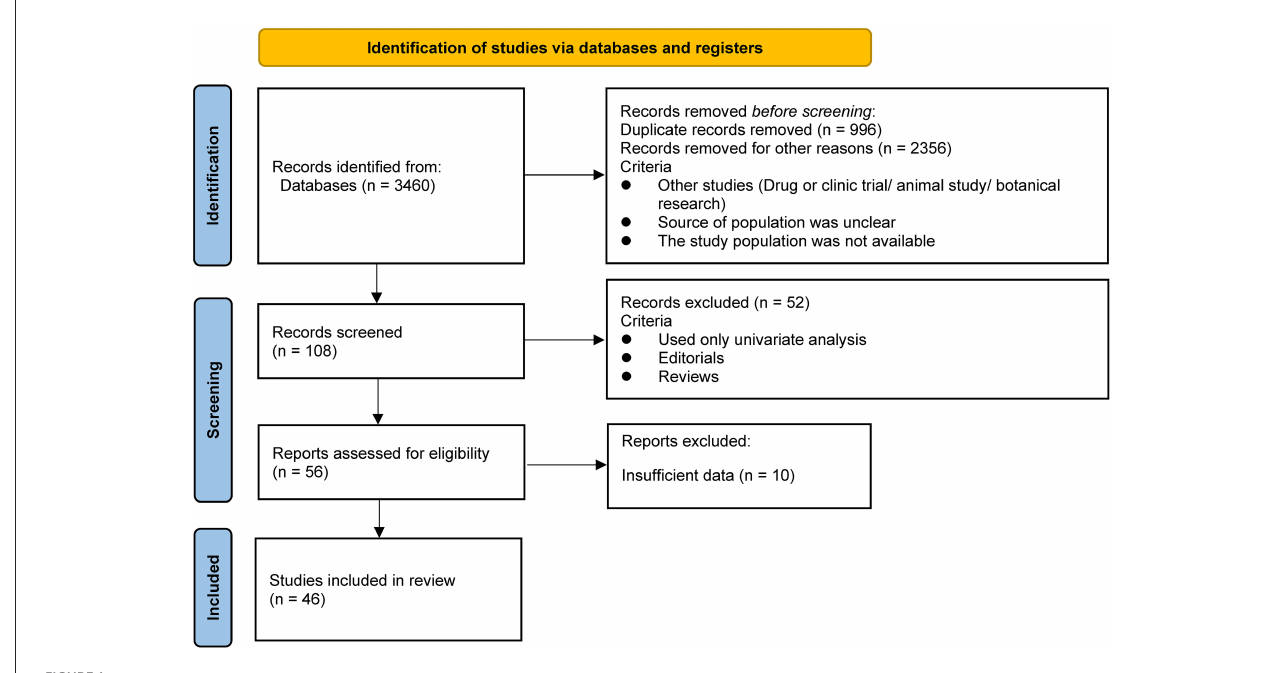
FIGURE1 PRISMA flow diagram for the study selection